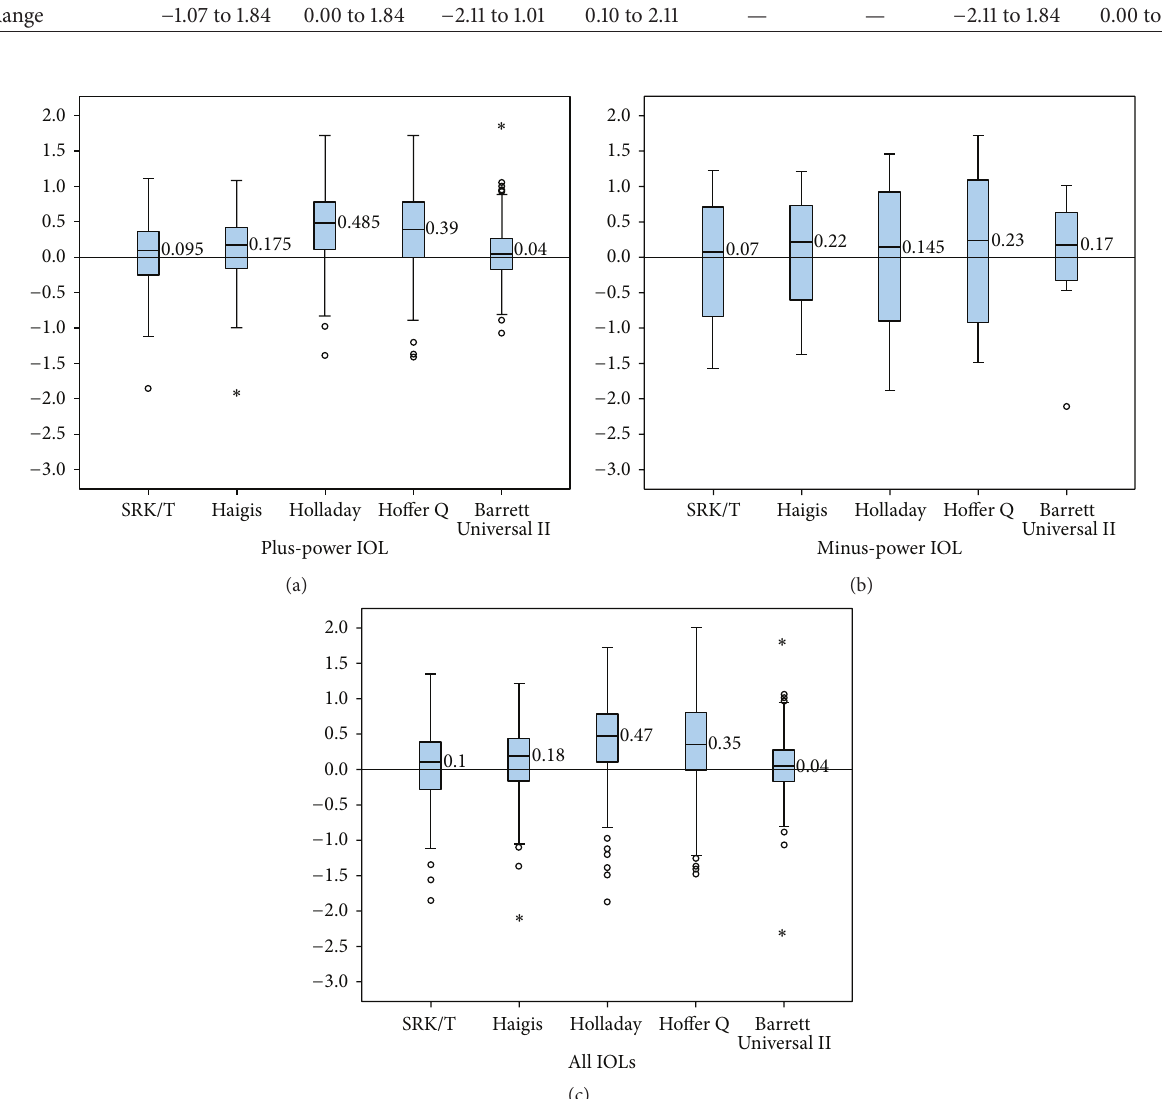
Figure 1: Mean numerical error in Group A and Group B. Group A were eyes with plus-power IOL; Group B were eyes with minus-power IOL. 𝑥 axis was formulas; 𝑦 axis was mean numerical